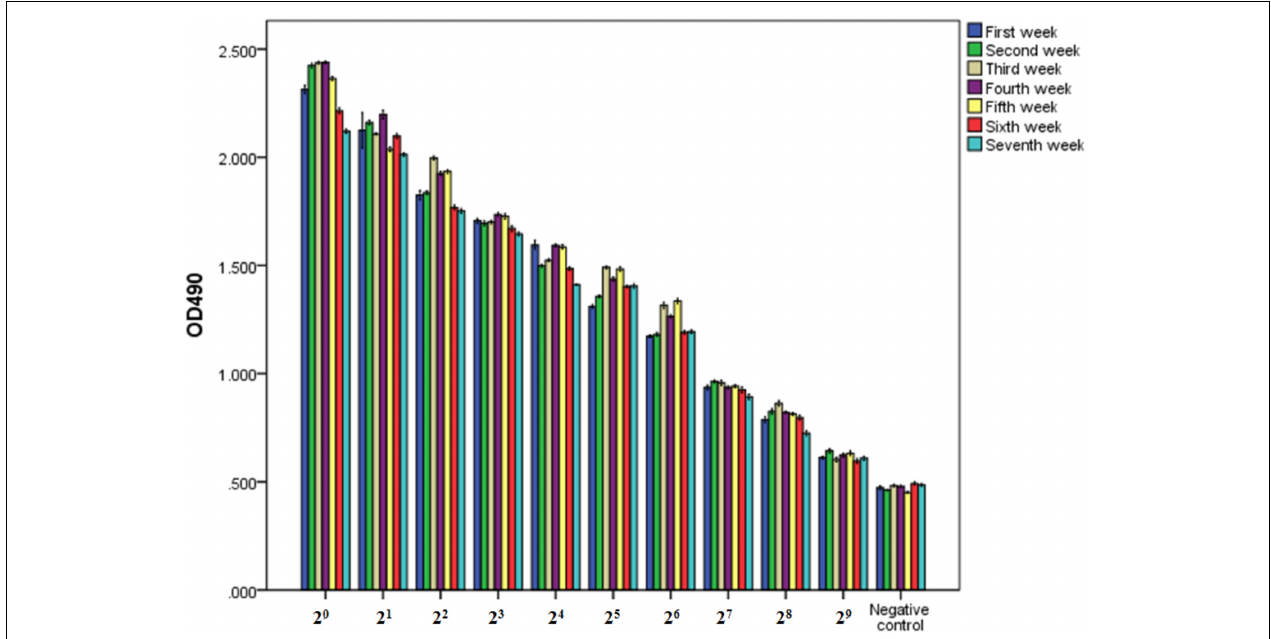
FIGURE 3 | Titer of combinations of IgY antibodies against CSBV detected by ELISA once a week from days 42 to 91 after the first immunization. The OD ratio of combinations of anti-CSBV specific IgY to the negative control was > 1.5 at 22, 23, 24, 25, 26, 27, and 28 dilutions, while the 29 dilution was < 1.5. The results indicated that the titer of combinations of anti-CSBV-specific IgY is 28. Bars represent SE.